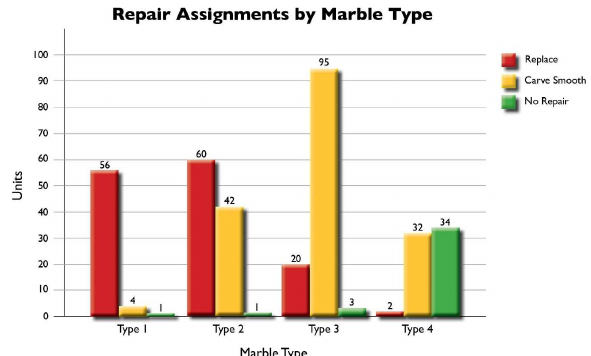
Figure 3: A graph tracking repair assignments by marble type for 350 block